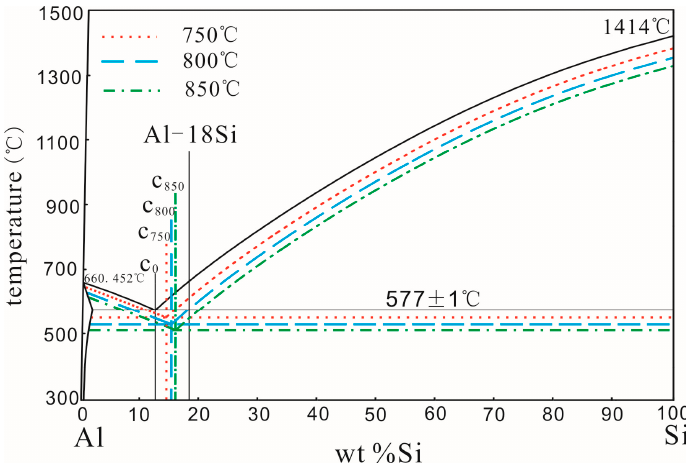
Figure 6. Schematic of eutectic point variation of the Al–Si alloy modified by 0.2 wt % Al–3B at different temperatures.